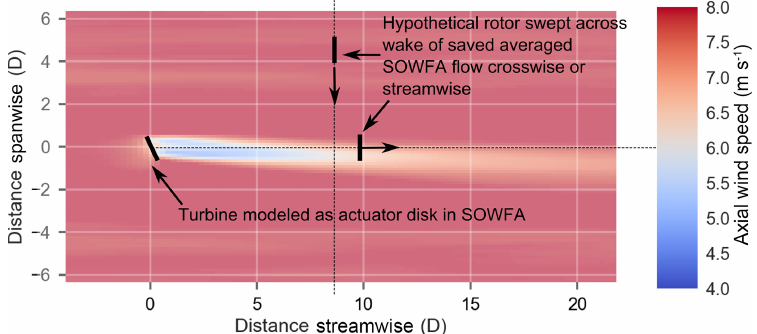
Figure 1. Diagram of the method used in the paper. In this example, showing the flow as viewed from above, a single turbine is included in a SOWFA simulation. A period of 1600s of the flow is averaged and then the hypothetical turbine rotor is scanned across this averaged flow to compute the power that would have been produced by a turbine at a given